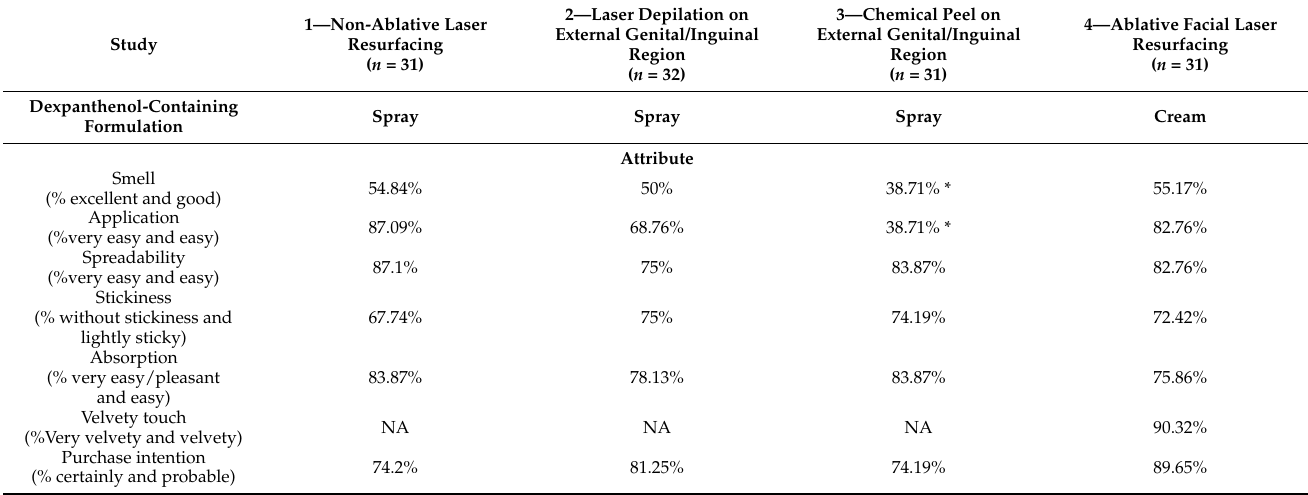
Table 5. Acceptability: assessment of physical attributes and purchase